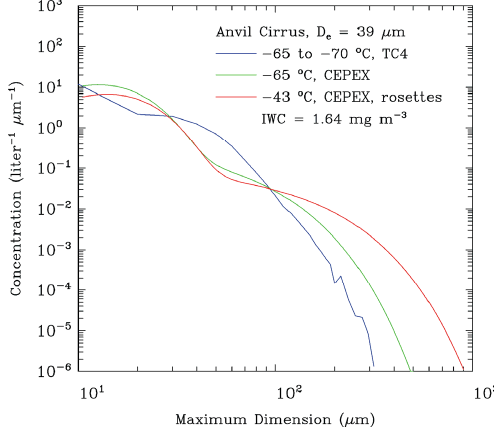
Figure 4. Experimental design for the anvil cirrus case study, based on the mean PSD sampled during TC4 between -65 and -70 o C (blue curve). The other two PSD were derived from a PSD scheme based on CEPEX data, evaluated at the indicated temperatures. The green curve contains approximately the same ice particle shapes (in terms of their mass and area attributes) as the measured PSD, while the red curve contains only bullet rosettes. All PSD are having the same D e and IWC.